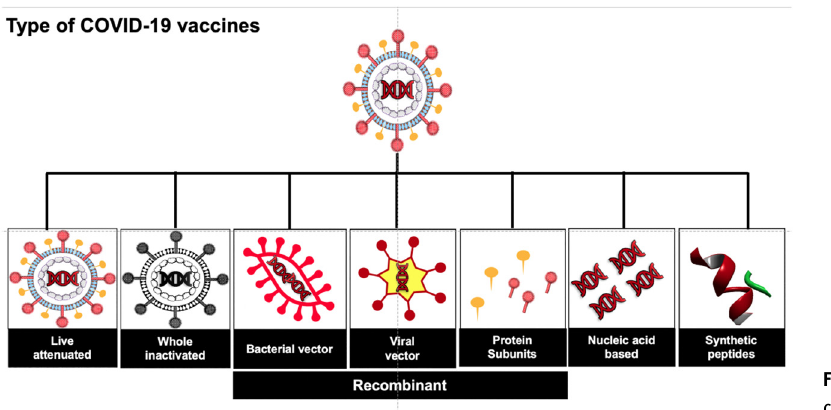
Figure3: TypesofCOVID-19vac-